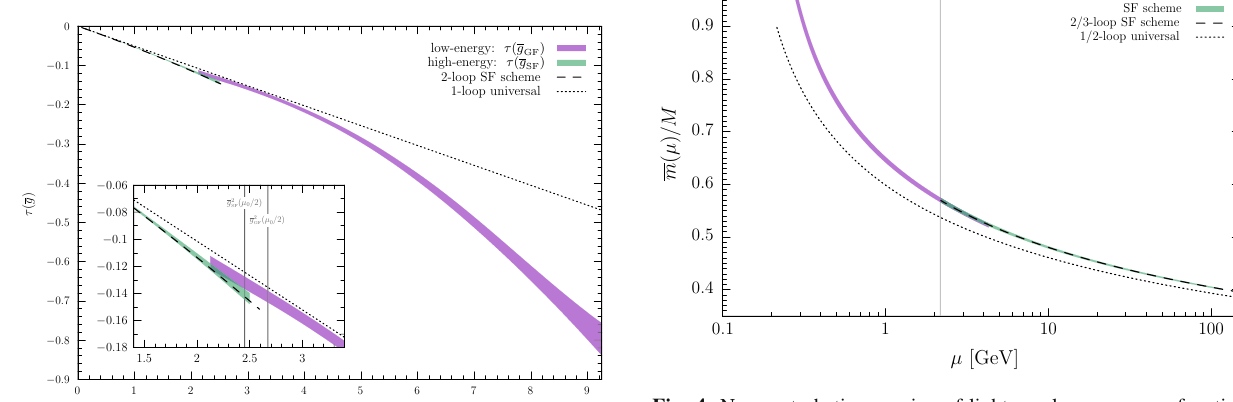
Fig. 4 Non-perturbative running of light quark masses as a function of the energy scale, down to our hadronic matching scale. The value of μ in physical units has been obtained by using the result for (cid:5) QCD in [31]. Perturbative predictions at different orders are also shown for